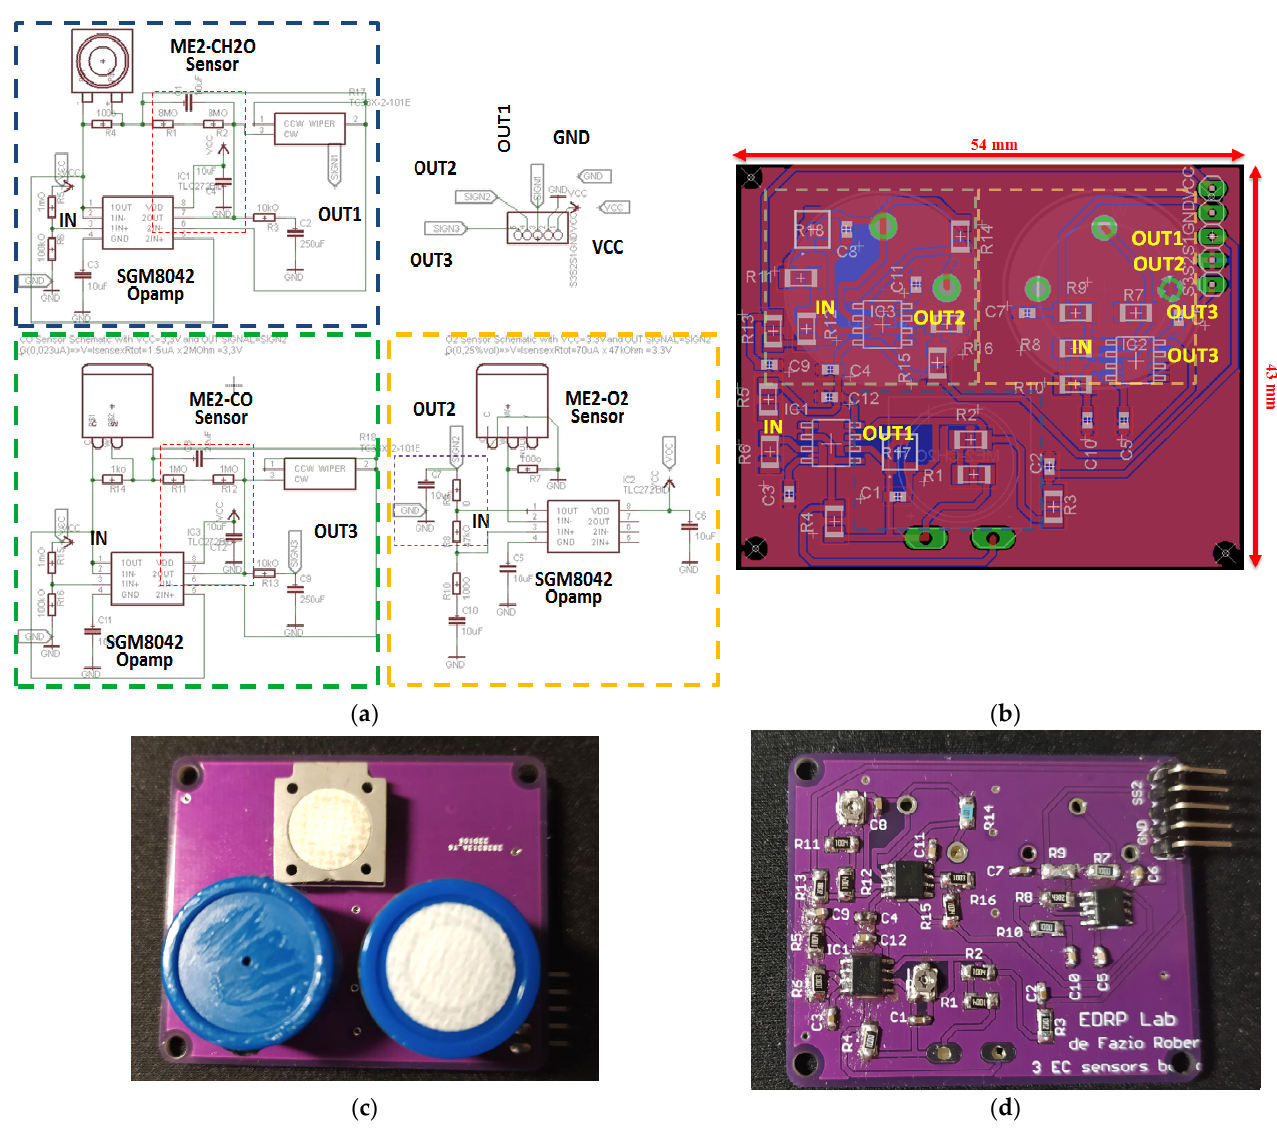
Figure 11. Schematic ( a ), layout ( b ), and PCB top ( c ) and bottom ( d ) views of the conditioning board of the ME2 family sensors. Diagrams were realized with Eagle CAD software.